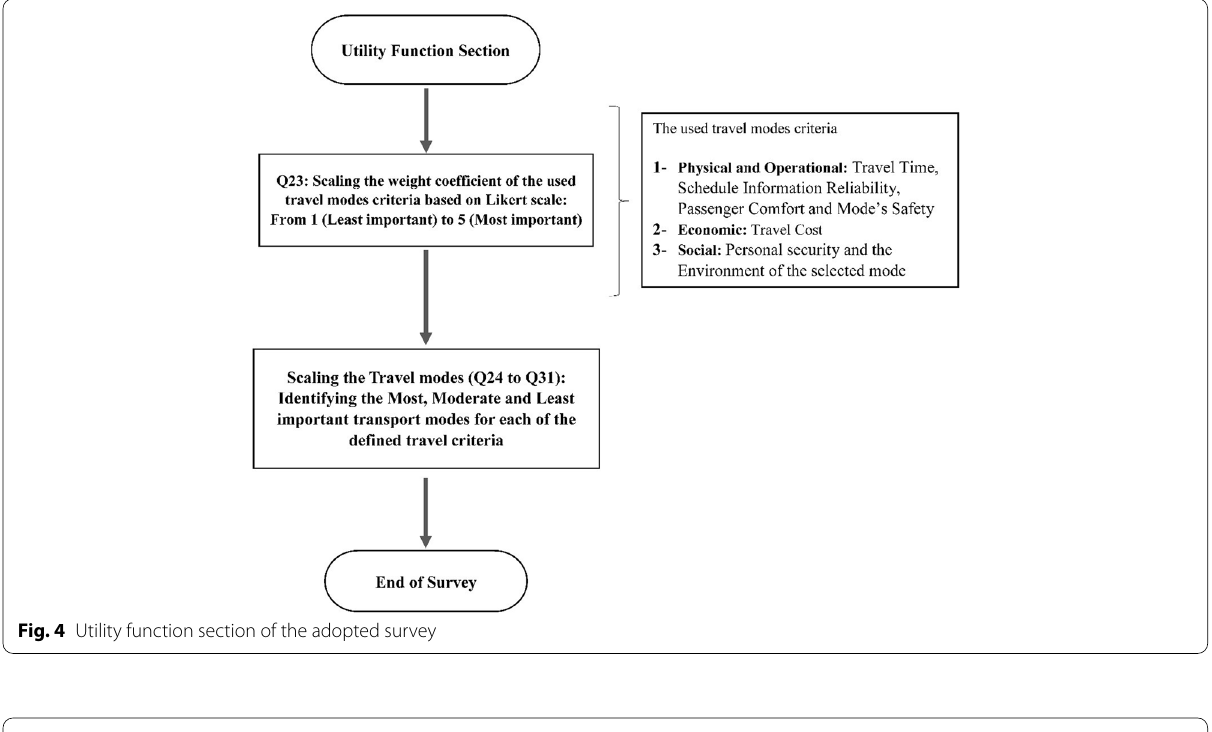
Fig. 4 Utility function section of the adopted survey